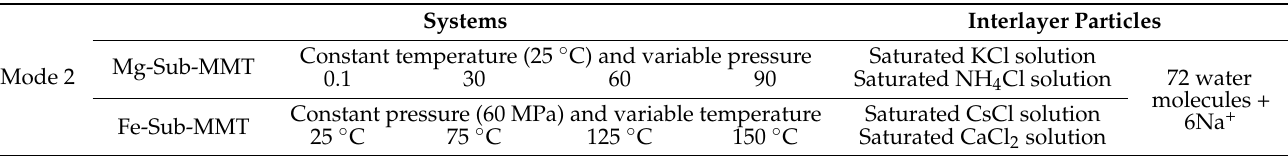
Table 2. Mode 2: Simulation scheme for changes of saturated inorganic salts under temperature and pressure conditions construction.